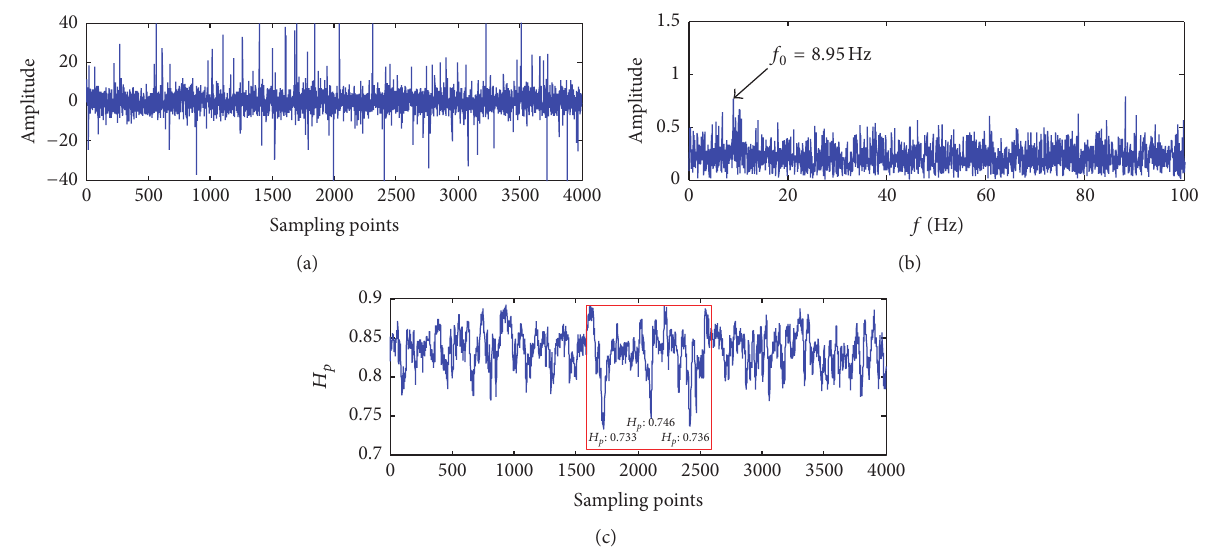
Figure 14: Heavy wear of floating tile. (a) Time-domain waveform of original signals, (b) frequency spectrum of original signals, and (c) PE of original